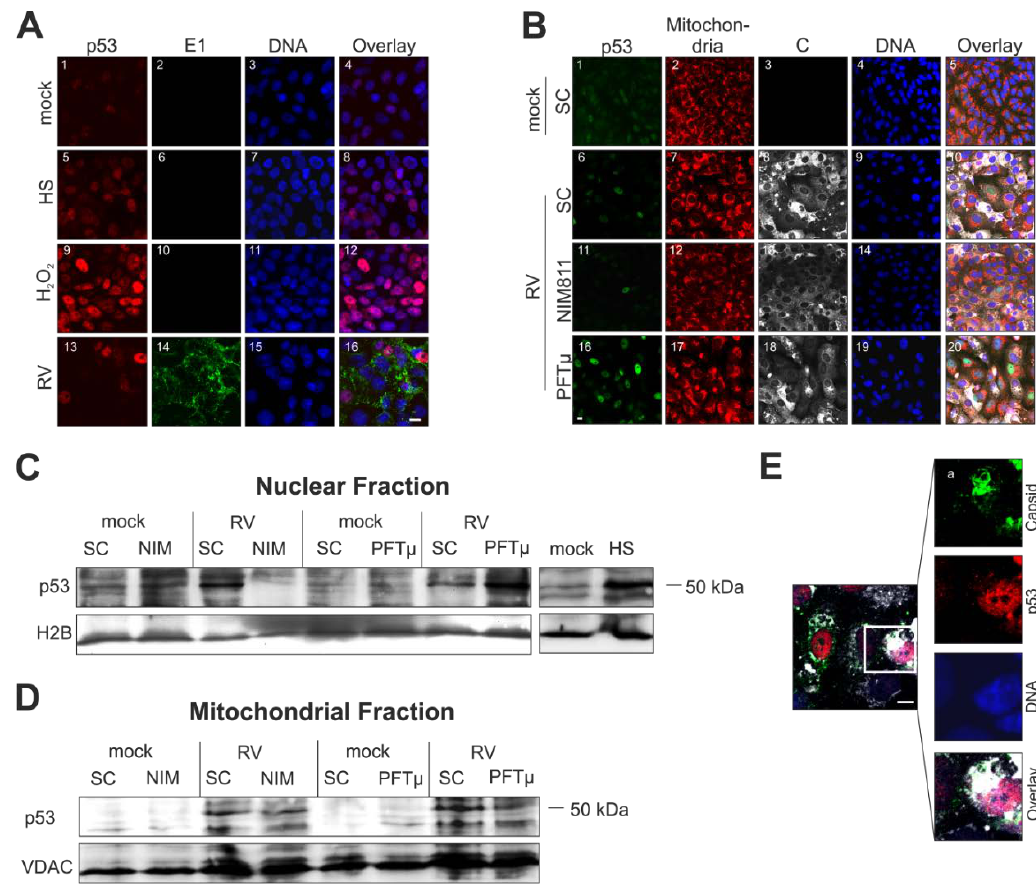
7 Figure 5. Impact of RV infection on intracellular distribution of p53. ( A ), ( B ), ( E ) Nuclear DNA is shown in blue. ( A ) Immunofluorescence analysis of mock- and RV-infected Vero cells with anti-p53 (shown in red) and anti-E1 (shown in green) at 3 dpi. Pink colour indicates overlap areas. As a positive (cid:5) (cid:5) control, heat shock (2 h at 43 C and 24 h at 37 C) and overnight incubation with 0.003% H 2 O 2 was included; ( B ) Three days after infection with RV in the presence of pharmacological inhibitors NIM811 (2 µ M) at 2 hpi and PFT µ (12.5 µ M) at 24 hpi) the expression of p53 was compared to the SC through immunofluorescence analysis with anti-p53 antibody (shown in green) and anti-C protein antibody (shown in white). As a counterstain, mitochondria were labelled with MitoTracker Red CMXRos (shown in red) before fixation. Western blot analysis of ( C ) a nuclear and ( D ) a mitochondrial fraction obtained from RV- and mock-infected cells at 3 dpi. Conditions applied are indicated. As a loading control, anti-histone 2B (H2B) and anti-VDAC antibody were applied. HS, heat shock condition; ( E ) Immunofluorescence analysis of RV-infected Vero cells at 3 dpi, the inset depicts p53 localization (shown in red) outside the nucleus, close to areas of C protein localization (shown in green) and mitochondria (shown in white, stained with MitoTracker DeepRed). SC, solvent control; scale bar, 10 µ